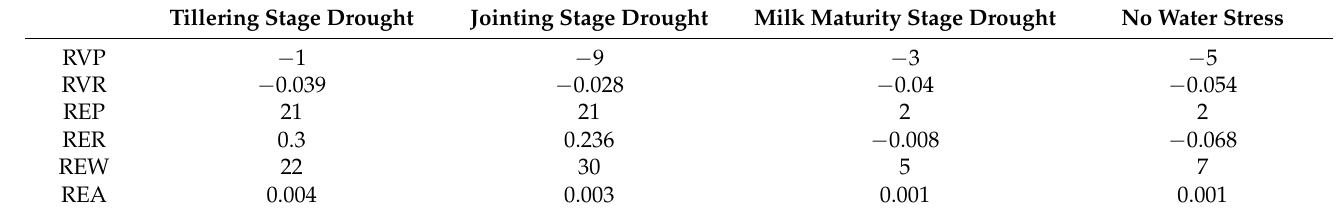
Table 5. Changes in the six red-edge parameters (the value was calculated by subtracting red-edge parameters obtained on Jan 9 with the red-edge parameters on Mar 5; + represents an increase in the red-edge parameters, while—represents a decrease in the red-edge